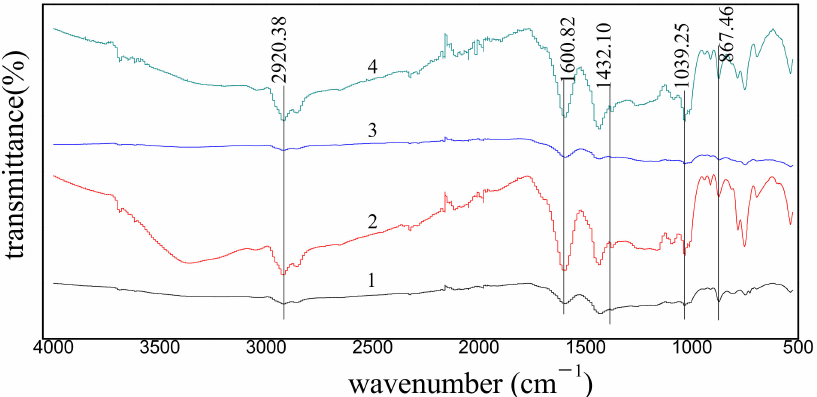
Figure 1. FT-IR spectra obtained from the raw coal and the residues after extractions. (1) Raw coal. (2) Residues from the microwave-assisted extraction (MAE). (3) Residues from the Soxhlet extraction (SE). (4) Residues from the ultrasonic-assisted extraction